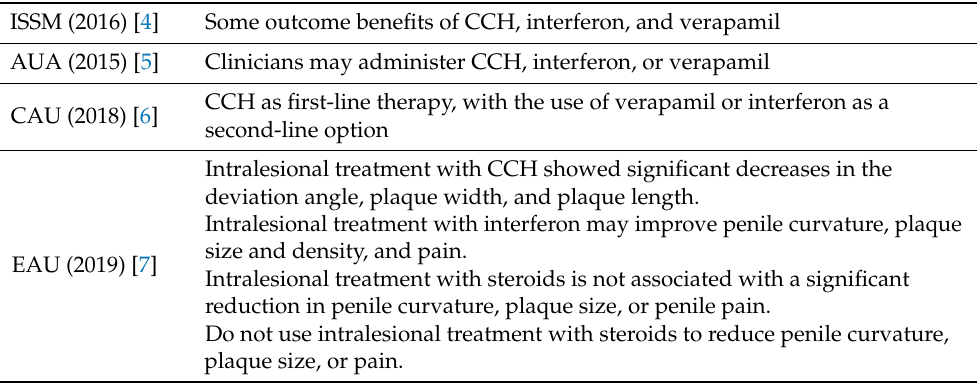
Table 1. Guidelines on Intralesional Therapy for Peyronie’s